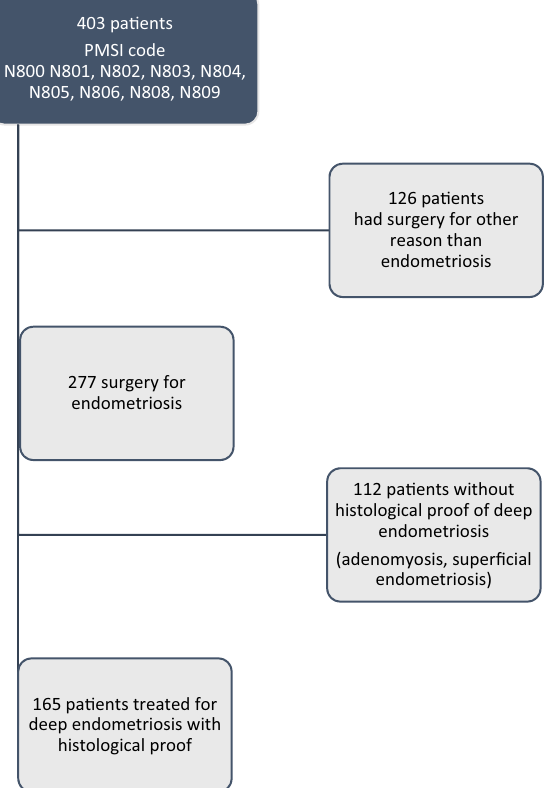
Figure 1. Flow chart of women screened and included into the study.